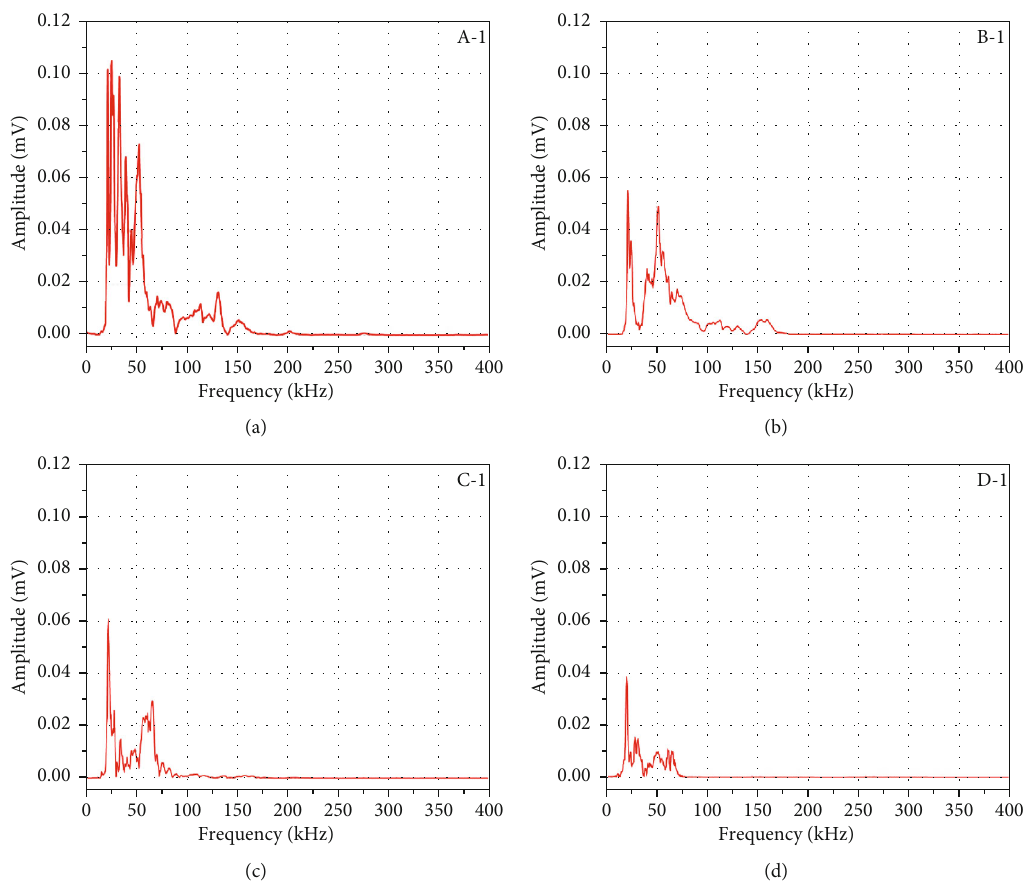
Figure 8: FFT spectrums of samples with di ff erent water contents.